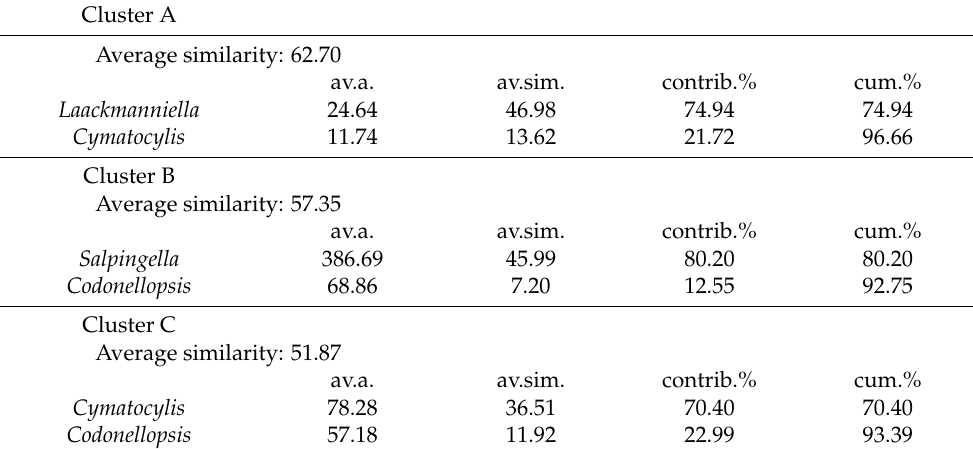
Table 6. SIMPER analysis within cluster performed on the genera abundance matrix. Average abundance (av.a.), average similarity (av.sim.), contribution % (contrib. %), cumulative % (cum.